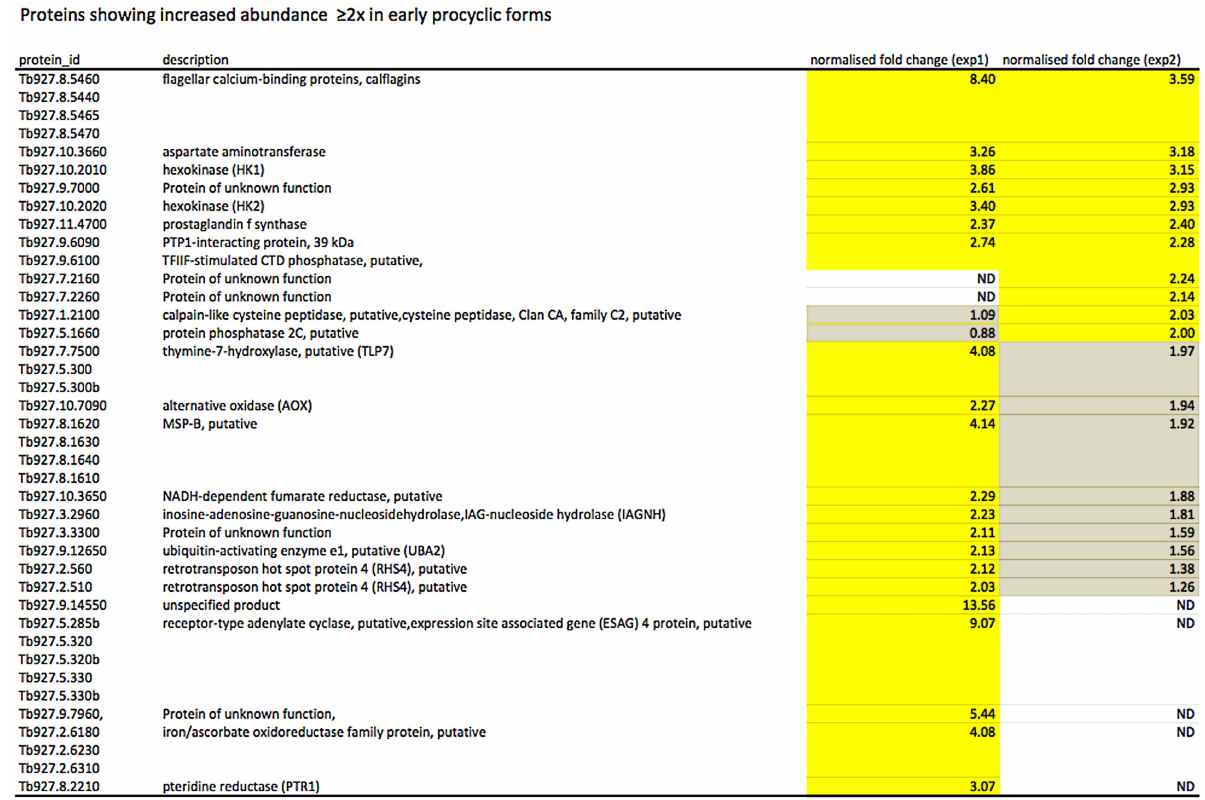
Figure 4. Proteins up-regulated in early procyclic forms. Yellow: proteins showing $ 2-fold increase in abundance. Grey: # 2-fold change in abundance. N.D. not detected. Biological replicates (exp1 and exp2) were